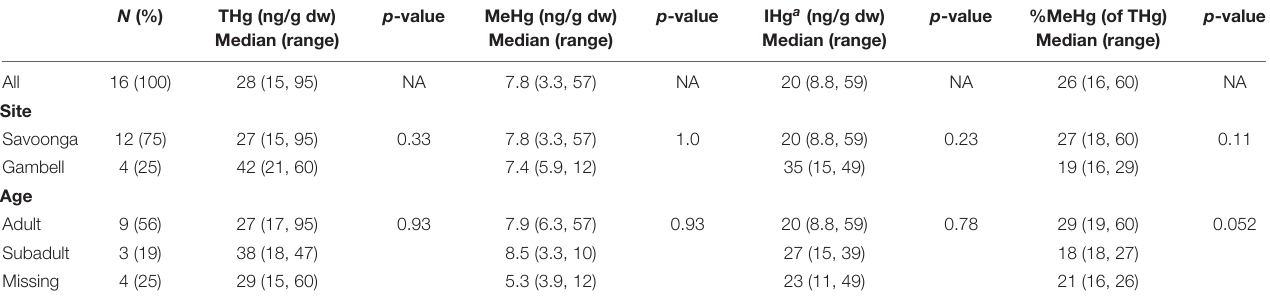
TABLE 2 | Associations between walrus characteristics and mercury concentrations in colon samples ( n = 16 walruses). N (%)